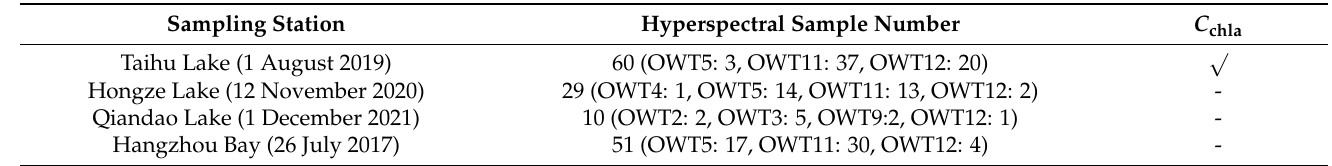
Table 1. Basic information of the four cruises. OWT represents optical water type. The detailed description of OWTs can be found in Section